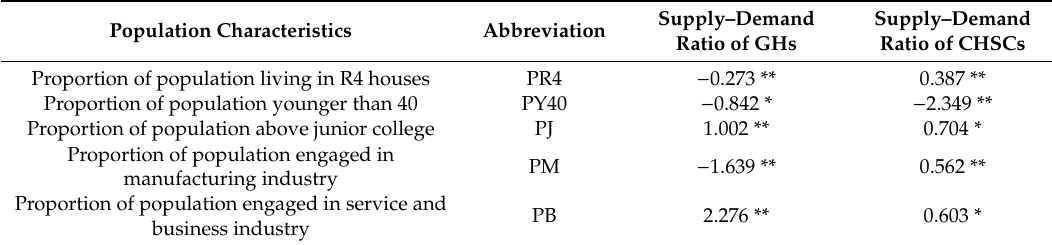
Table 2. The correlations between the supply–demand ratio of GHs/CHSCs and population characteristics.